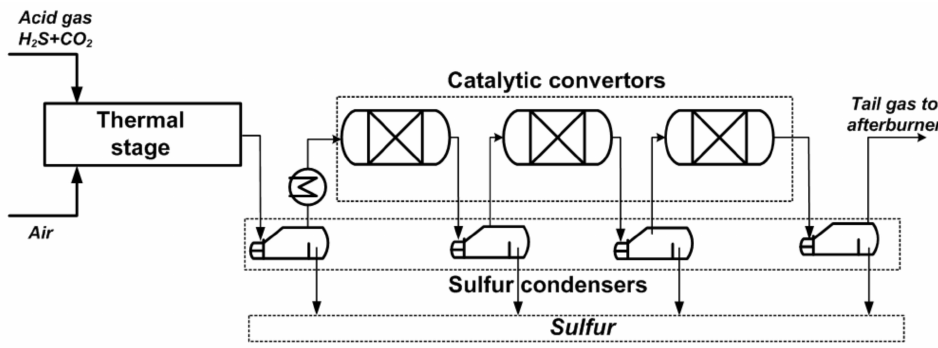
Figure 30. Schematic diagram of the Claus plant operating at the Minibay GPP.